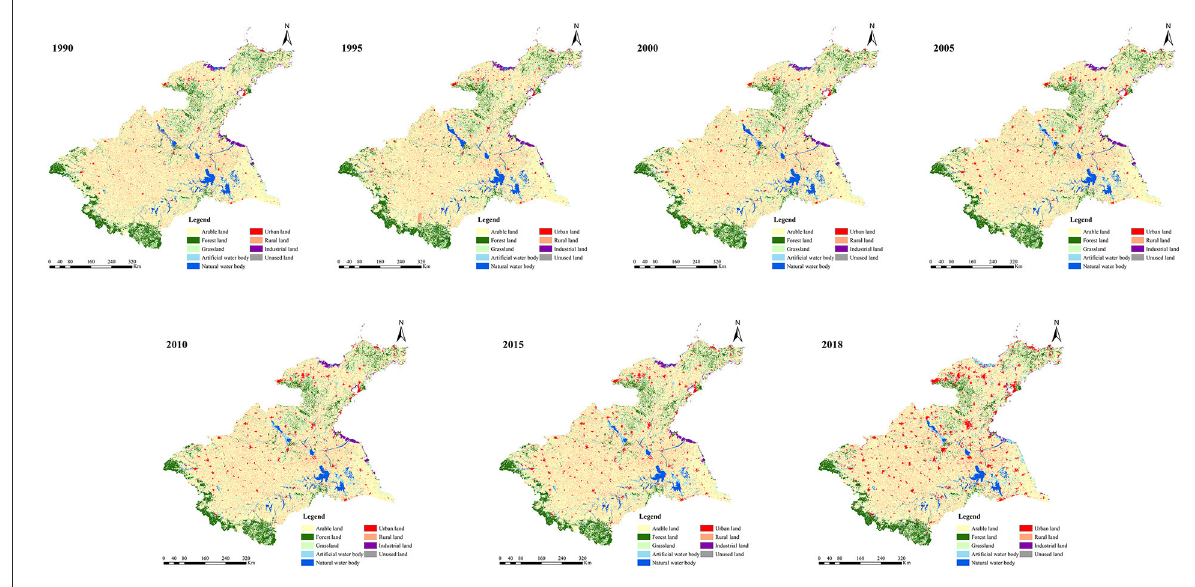
FIGURE3 Temporal changes in land use types of the Huaihe River Basin over the 1990–2018 period.